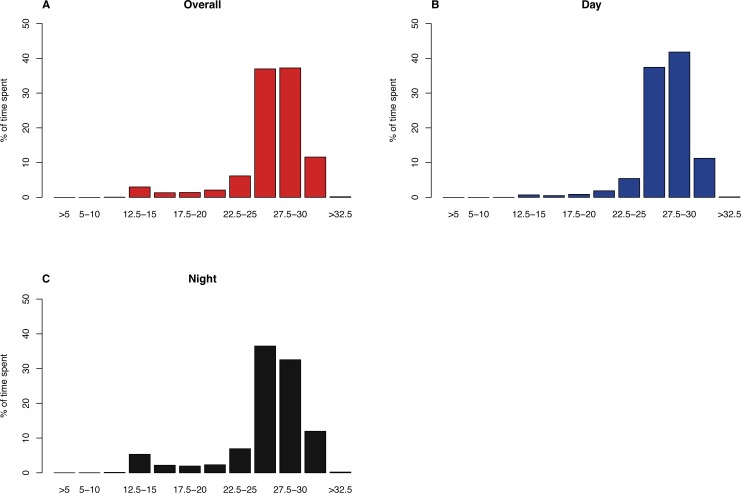
Time-at-temperature histograms for all whale shark tags combined, with (A) overall results, (B) daytime observations (6 am–6 pm) and (C) nighttime observations.